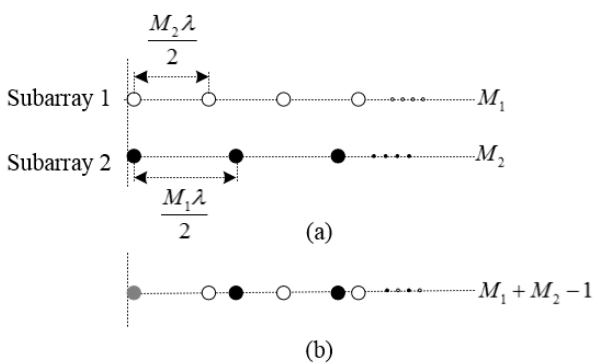
Figure 1. Topological structure of a coprime linear array (CLA): ( a ) Two uniform linear subarrays; ( b ) Coprime array formed by aligning the above two linear subarrays.